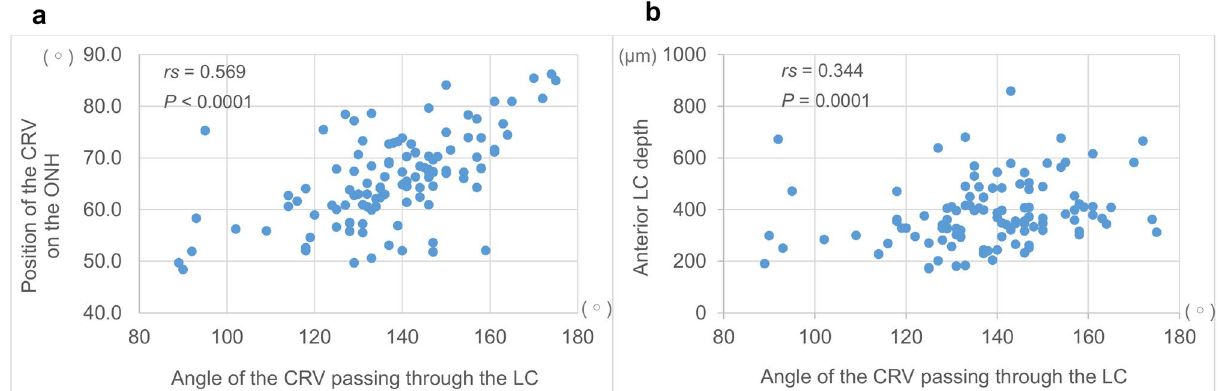
Figure 4. ( a ) Correlation between the angle of the central retinal vessel (CRV) passing through the lamina cribrosa (LC) and its position on the optic nerve head (ONH) in eyes with glaucoma. ( b ) Correlation between the angle of the CRV passing through the LC and the anterior LC depth in eyes with glaucoma. A higher degree of the angle of the CRV passing through the LC indicates a more nasally angled path, and higher percentage of the position of the CRV on the ONH indicates a more nasal position of it. Univariate analysis Multivariate analysis Regression coefficient (95% confidence intervals) Standard regression coefficient (95% confidence intervals) Mean deviation − 0.270 (− 0.449 to −